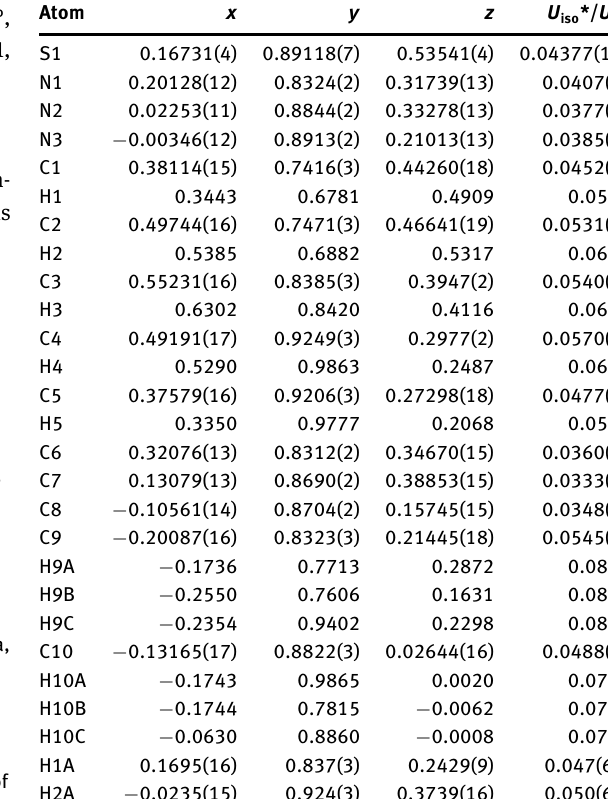
Table 2: Fractional atomic coordinates and isotropic or equivalent isotropic displacement parameters (Å 2